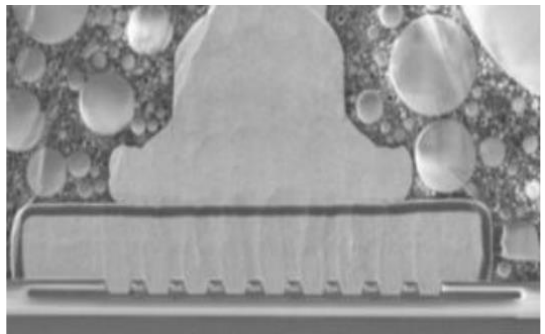
Fig. 9 . Image X-Ray Transistor MOSFET